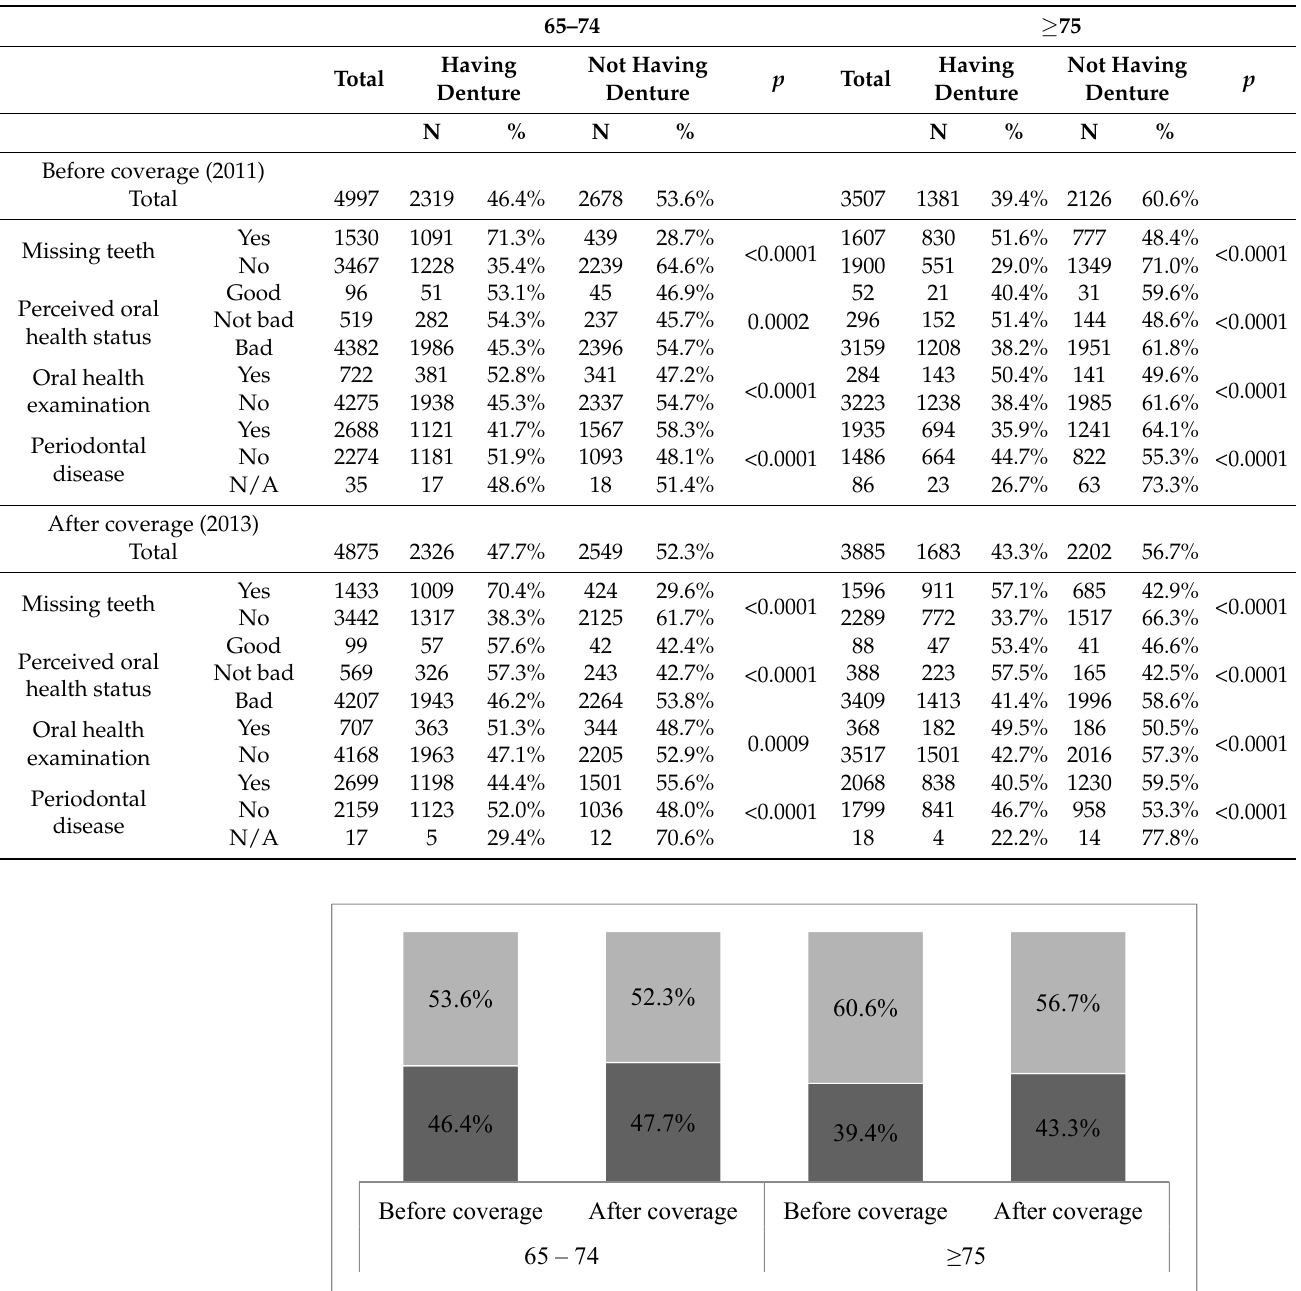
Table 1. Dental-health-related characteristics of study participants before and after coverage.